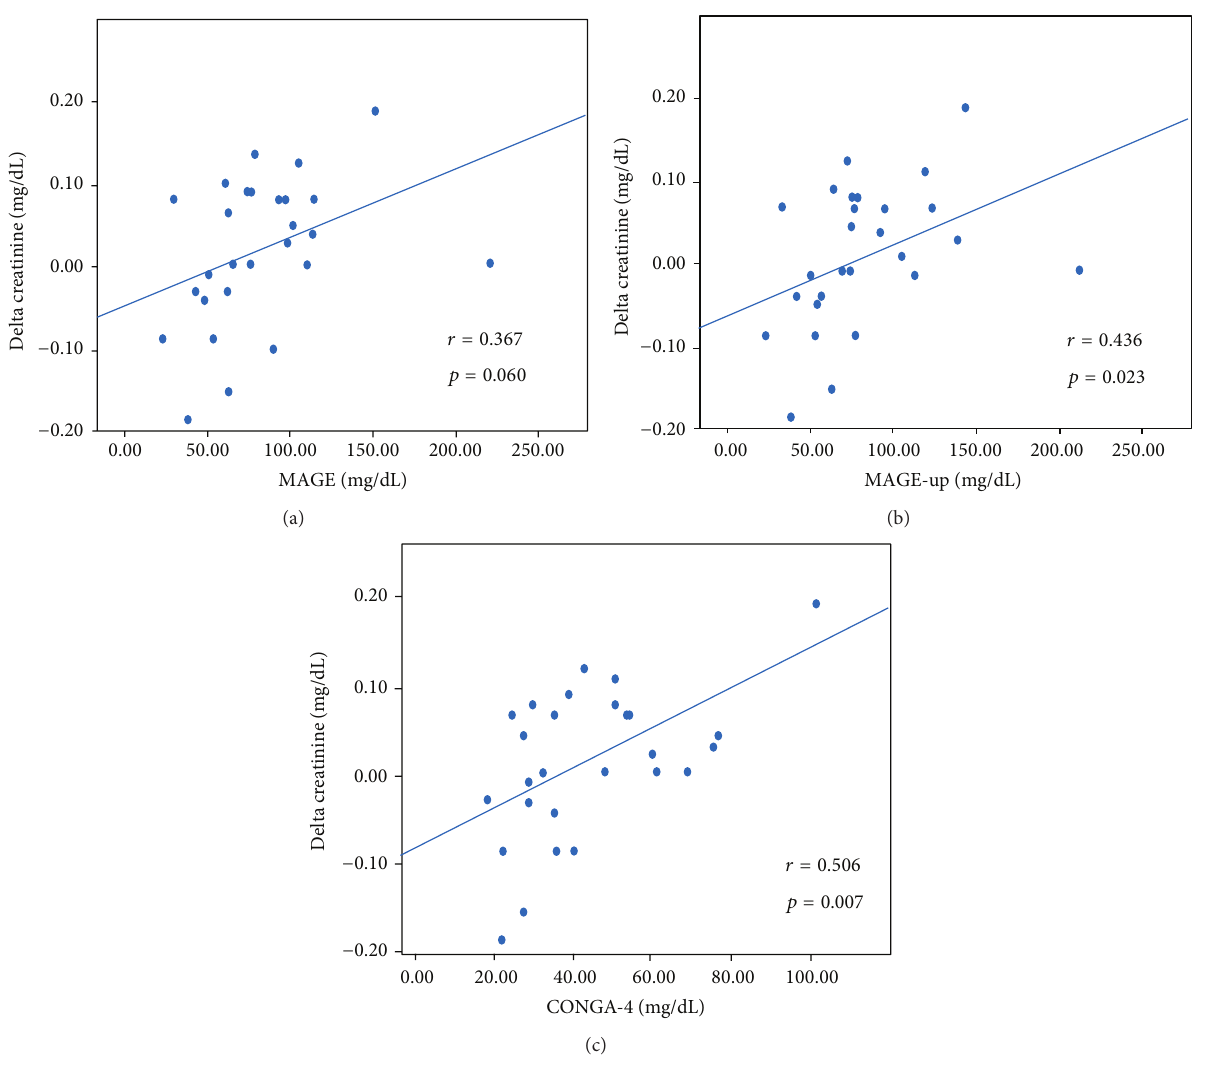
Figure 2: Correlation between periprocedural glycemic variability (expressed as MAGE, MAGE-up, and CONGA-4) and postprocedural serum creatinine variation. CONGA-4: continuous overall net glycemic action at 4 hours; MAGE: mean amplitude glycemic excursions; MAGE-up: mean amplitude glycemic nadir-to-peak